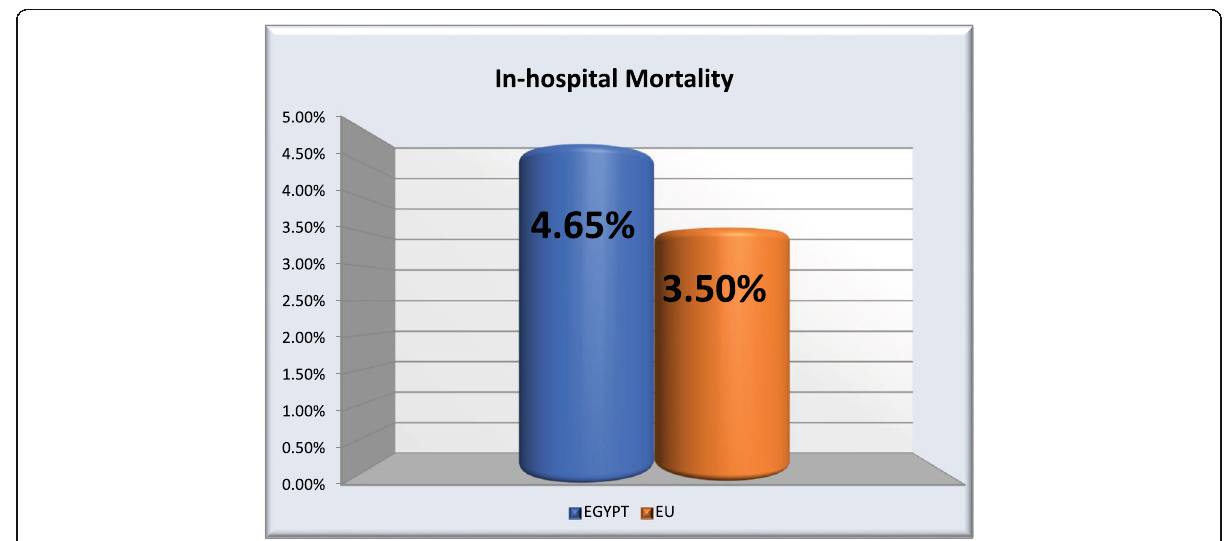
Fig. 3 In-hospital mortality in Egypt vs. other